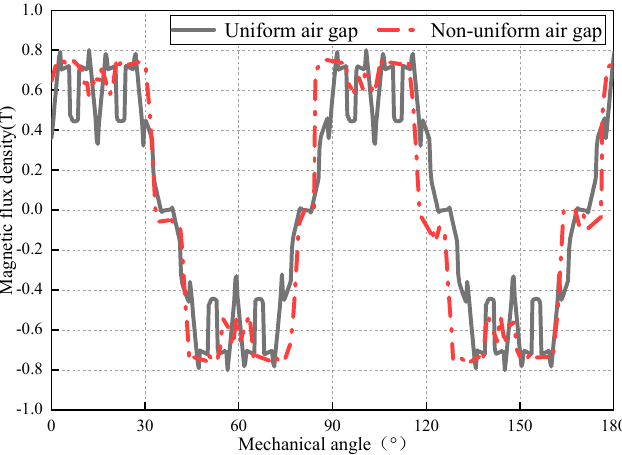
Figure 9. Comparison diagram of magnetic flux density with different air gaps.